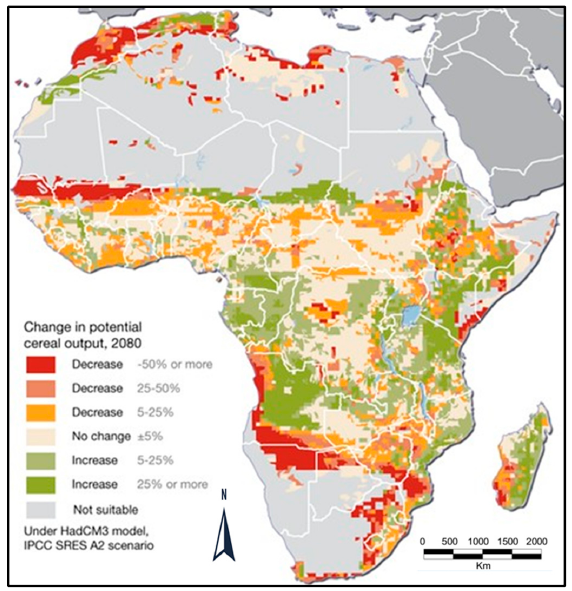
Figure 6. Projected changes in cereal productivity in Africa, due to climate change—current climate to 2080. Reproduced with permission from Ahlenius, H, The Environmental Food Crisis—The Environment’s Role in Averting Future Food Crises , published by UNEP/GRID-Arendal, 2009. Most western parts of Southern Africa will be unsuitable for cereal productivity (Figure 6), while cereals are a major staple in the region. Other parts in the north and east would experience decreases in potential cereal output by 50% or more by 2080. One of the contributing factors to these impacts is increased water scarcity resulting from changes in climate and higher demand for water [1]. Areas in the further north in Angola, The Democratic Republic of Congo (DRC), parts of Zambia and Mozambique in the east would experience increases of 25% or more, however, these are small compared to the larger areas that would be unsuitable for cereal production and or would experience substantial decreases of at least 50%. The changes in agricultural productivity are projected based on expected increases in warming, changes in rainfall patterns and carbon fertilization for plants [1]. Again, the western parts covering Botswana, Namibia, South Africa, Zambia, and Zimbabwe; and Madagascar in the east would experience reduced agricultural productivity by between 15% and 50%. The rest of the region would